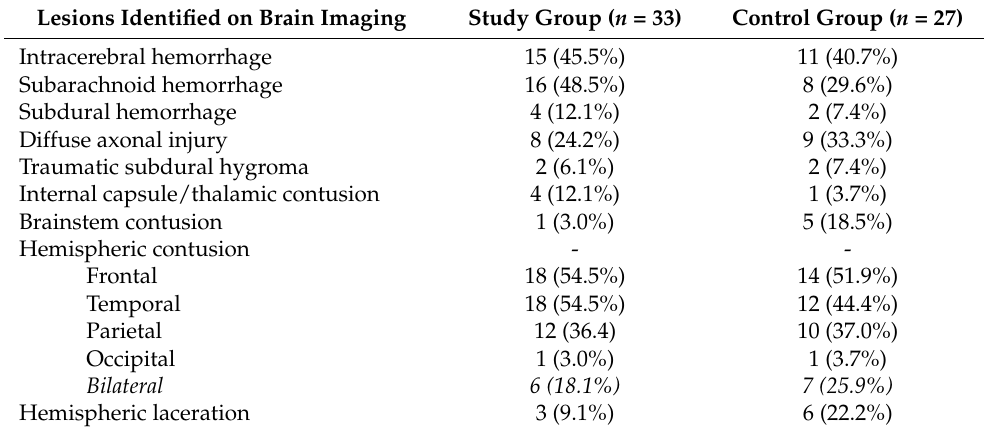
Table 1. Cerebral computed tomography findings at admission for all patients included in the study. Lesions Identified on Brain Imaging Study Group ( n =